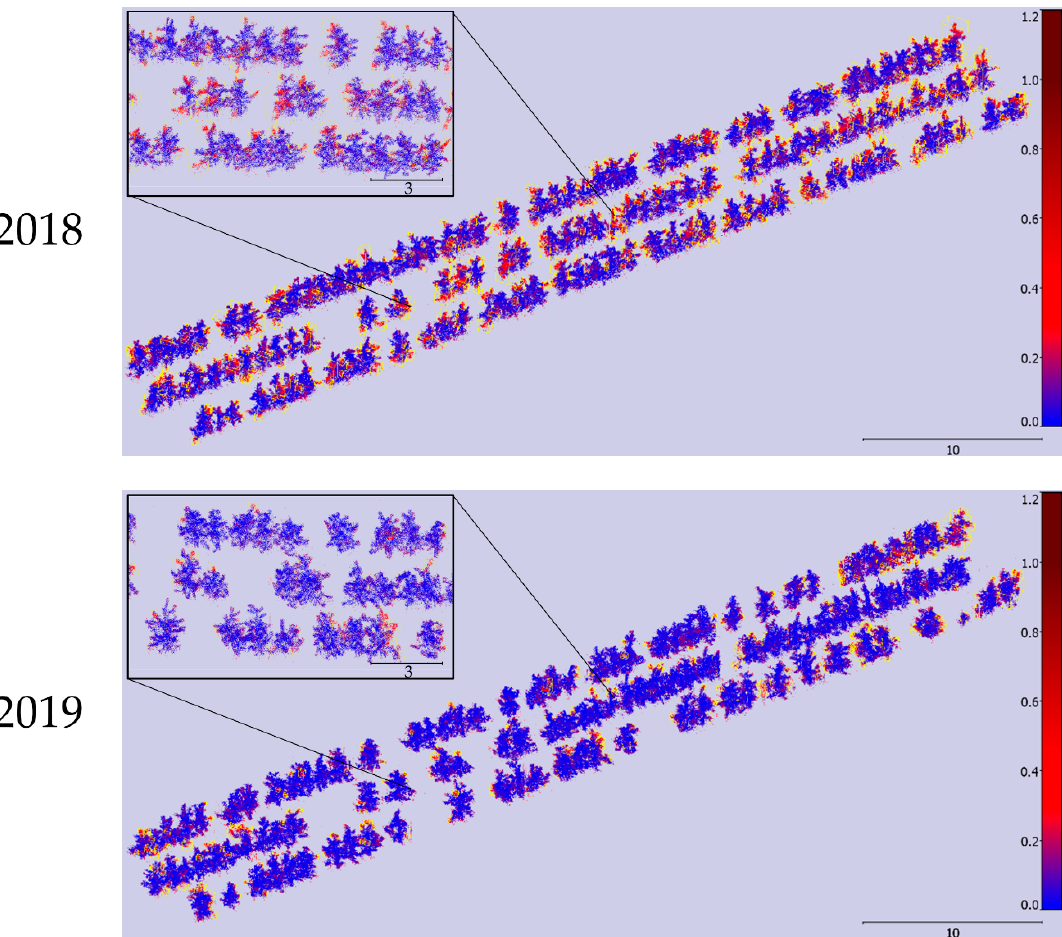
Figure 7. Detected areas of underestimation (yellow boxes) in UAV point cloud compared to LiDAR point cloud (color indicates distance to the nearest point in reference point cloud; all distances are given in meters) depicted as overview and magnified for a subsection.